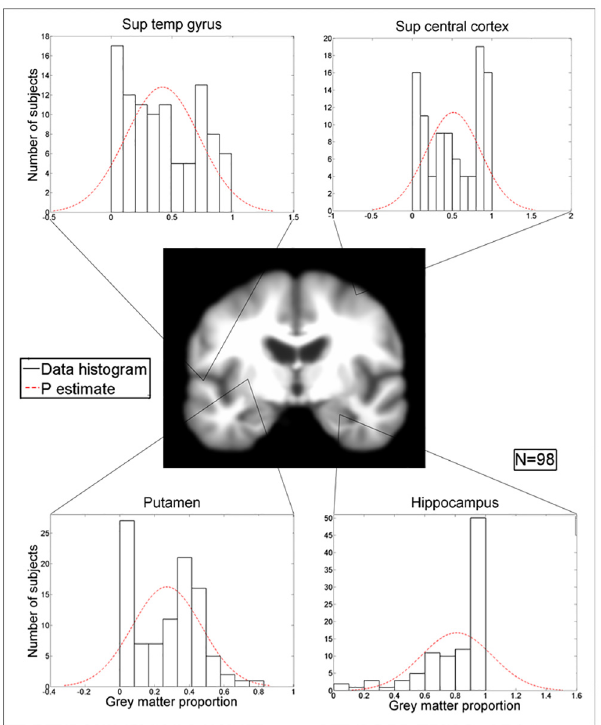
Fig 6. Distribution of the proportions of grey matter in 98 normal subjects (aged 60 – 90 years) at randomly selected voxels in the superior temporal gyrus (top left), superior central cortex (top right), putamen (bottom left), and hippocampus (bottom right). These distributions are markedly different to the assumed Gaussian (P) distribution (red dashed line).